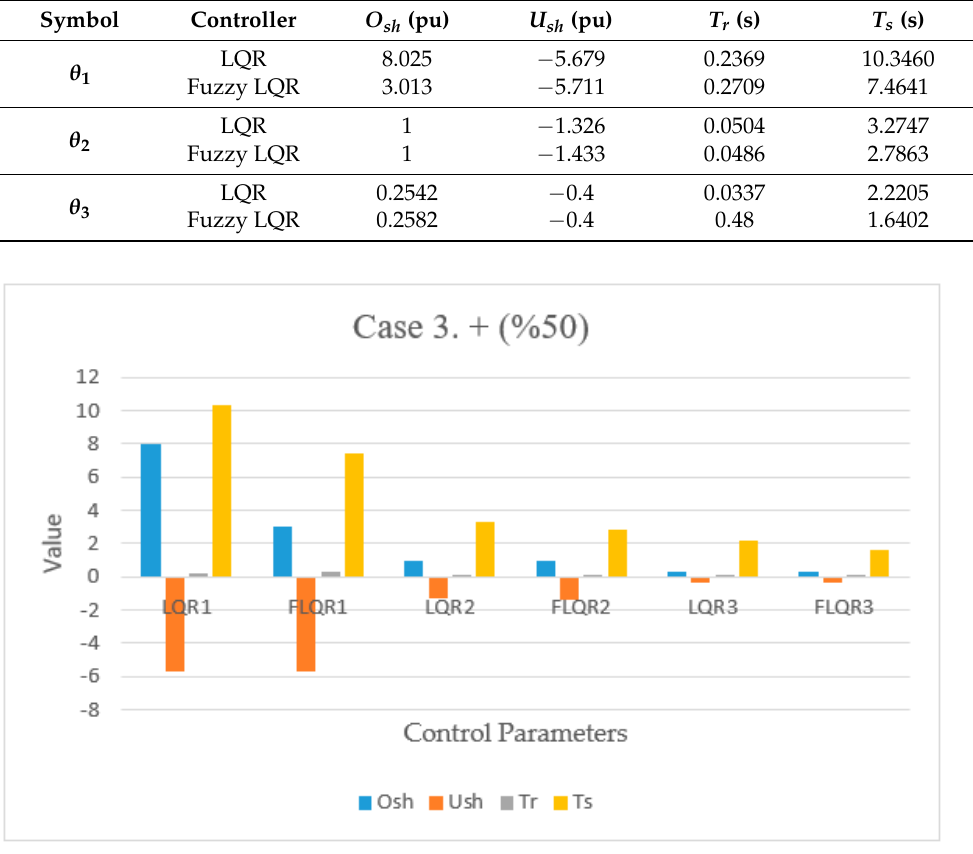
Table 6. Comparison performance of LQR and FLQR controllers in Case 3.